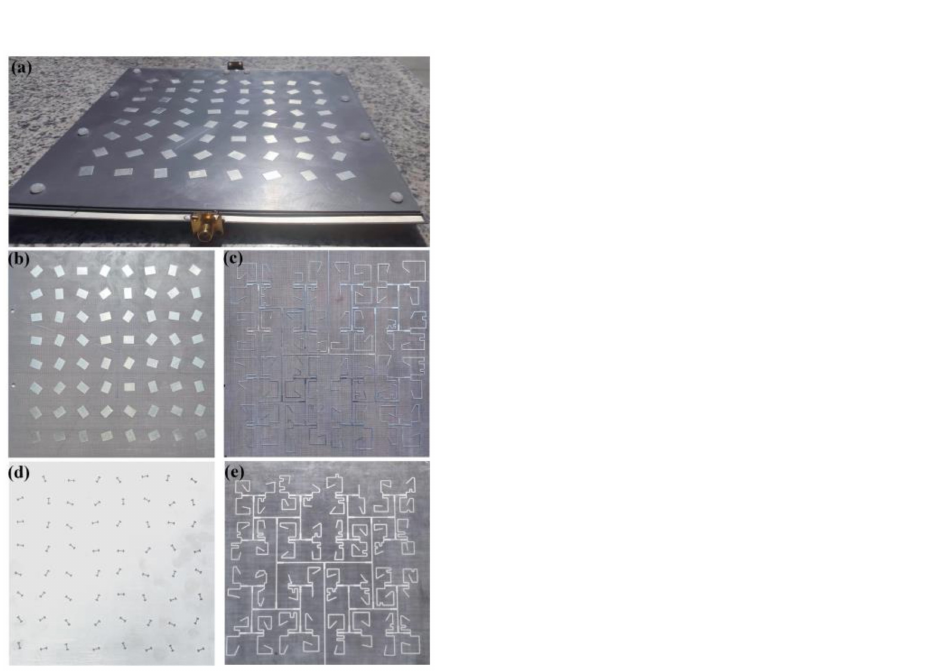
Figure 9. Photographs of the final fabricated quad-vortex-beam planar microstrip array. ( a ) Assem- bled model, ( b ) radiating elements, ( c ) upper feeding network, ( d ) ground plane with H slot, and ( e ) bottom feeding network.